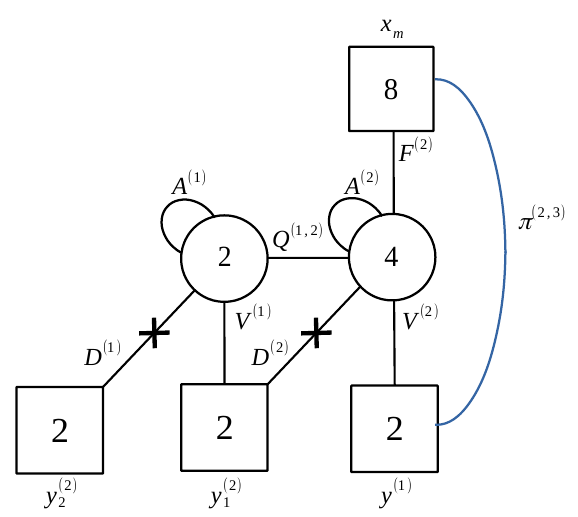
Figure 23 . The quiver diagram representation of E denoted by crosses, (cid:13)ip Tr 1